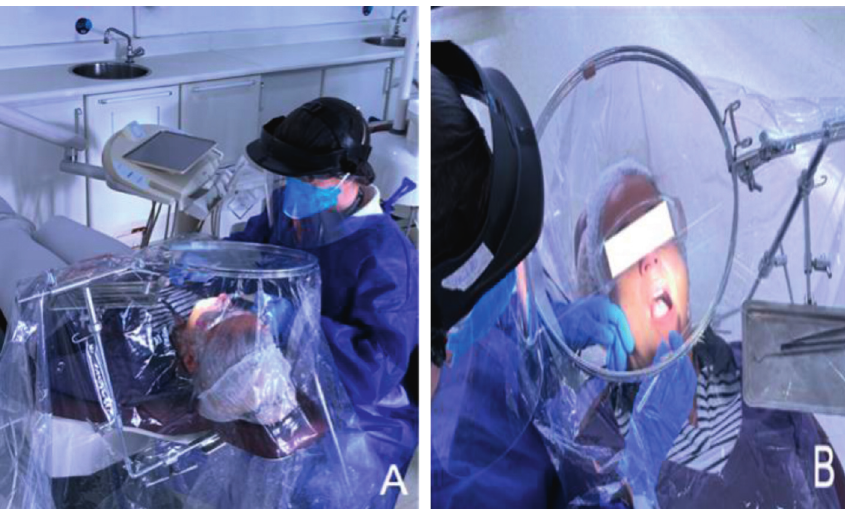
Figure 1: a and b) show the individual biosafety capsule device (IBCD) to the dental chair. The overhead ring can be adjusted to be rotated in all 3 dimensions, pitch, roll, and yaw in order to provide best visualization as well as freedom on hand and arm movements during